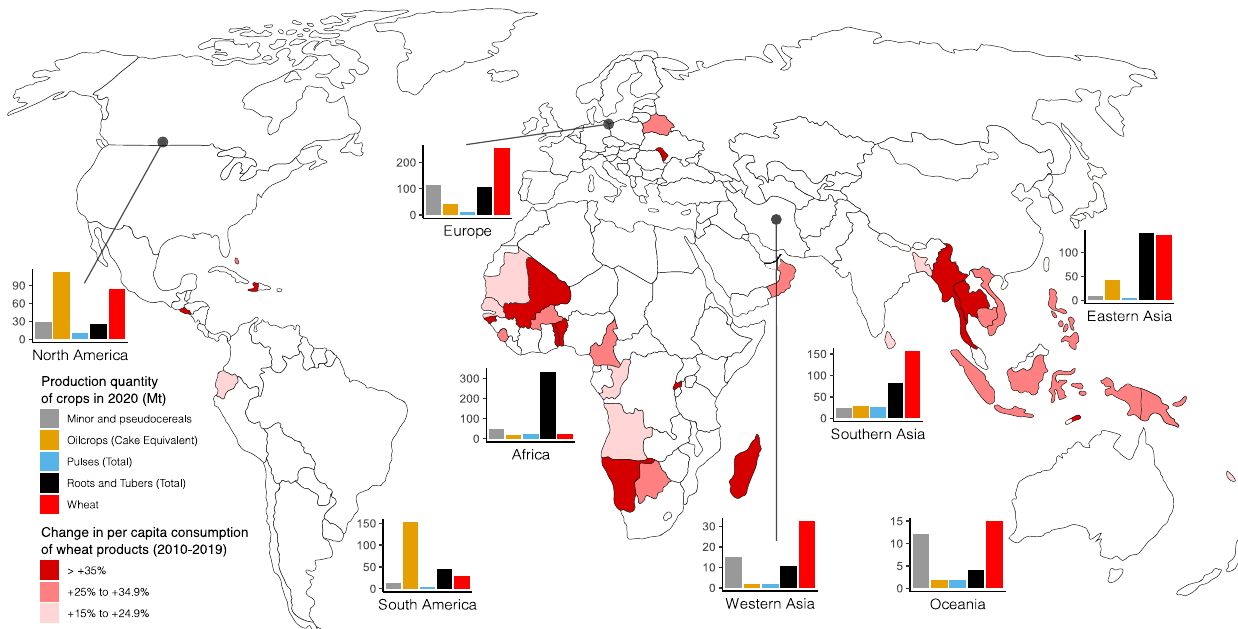
Fig. 2 Global production of selected climate-resilient crops (CRCs) and wheat in 2020, and countries with increased consumption of wheat products between 2010 and 2019. The production quantity of fi ve crop types mentioned in the present review is presented as bar charts. Crops belonging to oil crops, pulses, roots and tubers are grouped according to FAO ’ s categories, whereas minor and pseudocereals include barley, buckwheat, millet, oats, quinoa, and sorghum. The unit of production quantity is million tonnes (Mt). The production quantity of individual countries is aggregated to the indicated regional level according to FAO ’ s categories. The consumption data is expressed as relative change. Data from FAO 5 (https://www.fao.org/faostat/en/#data, accessed